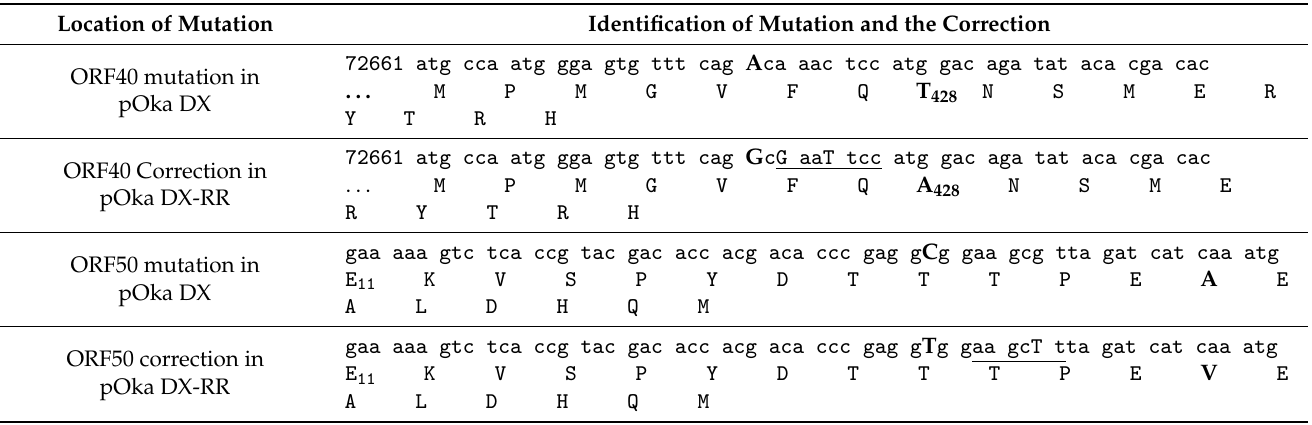
Table 2. Spurious mutations detected in pOka-DX BAC and their